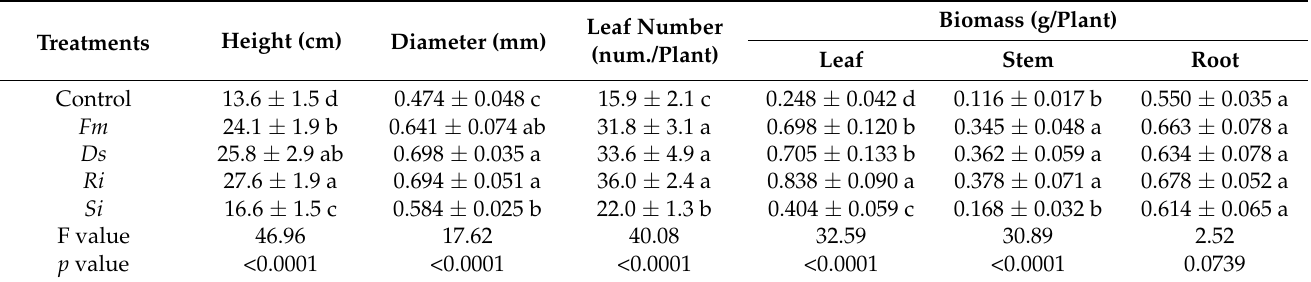
Figure 2. Plant growth response of Vicia villosa seedlings by inoculation with arbuscular mycorrhizal fungi and Serendipita indica after 63 days. For abbreviations see Figure 1. Table 1. Effects of inoculation with symbiotic fungi on plant growth of Vicia villosa